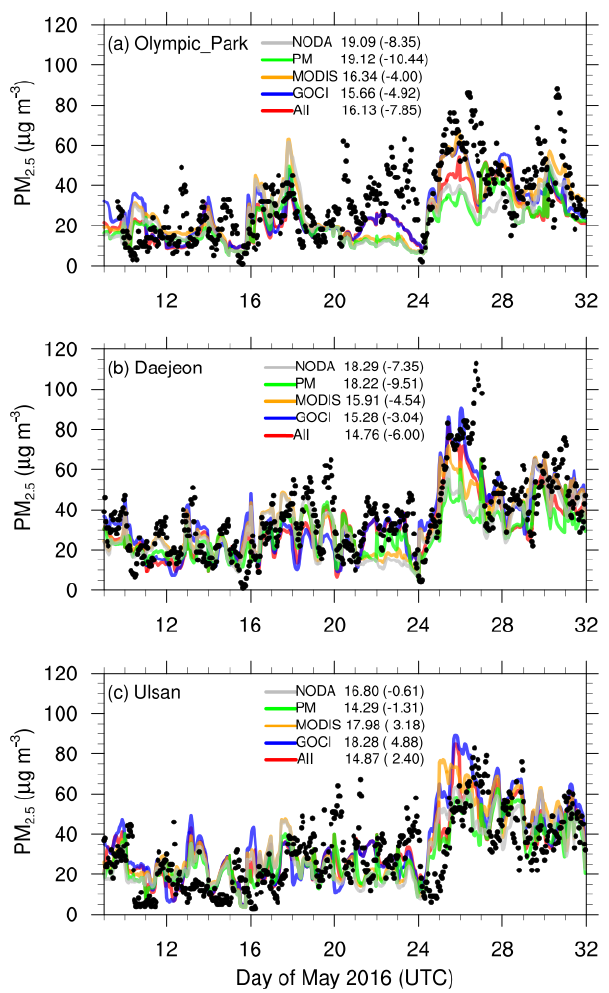
Figure 14. Same as Fig. 13, but for surface PM 2 . 5 concentrations from 00:00UTC on 9 May to 23:00UTC on 31 May at (a) Olympic Park in Seoul, (b) Daejeon, and (c) Ulsan. The sites are marked as red open dots in Fig. 12. The RMSE over the whole period is written next to each experiment name, along with the mean bias (represented as f–o) in